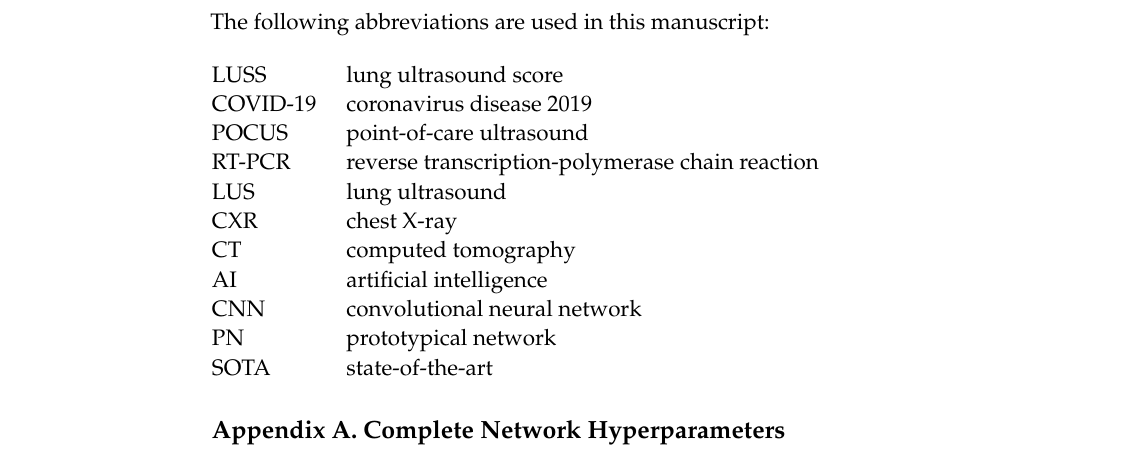
Table A1. Network Structure Hyperparameters.